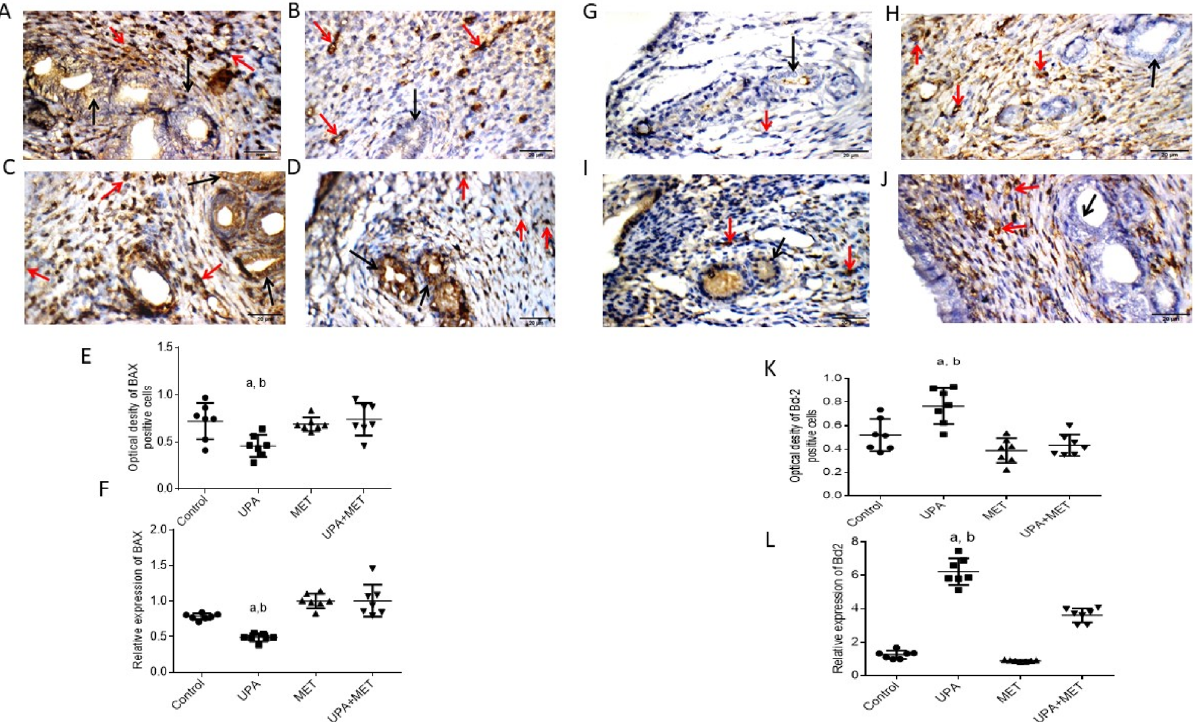
Figure 4. Effect of metformin or/and ulipristal on the expression of the proliferation markers of rats’ uteri. ( A – D ) photomicrographs of uteri shows expression of PCNA ( A ) Uterine wall in the control group. ( B ) Uterine wall in ulipristal treated group. ( C ) Uterine wall in metformin treated group. ( D ) Uterine wall in the ulipristal and metformin treated group. × 400 magnification (scale bar = 20 μm). ( E ) Expression quantification of the optical density reactivity of positive cells of PCNA by the ImageJ analysis system. ( F ) Quantitative RT-PCR analysis of PCNA mRNA expression. ( G – J ) Photomicrographs of uteri shows expression of Cyclin-D. ( G ) Uterine wall in the control group. ( H ) Uterine wall in ulipristal treated group. (I) Uterine wall in metformin treated group. ( J ) Uterine wall in the ulipristal and metformin treated group. × 400 magnification (scale bar = 20 μm). ( K ) Expression quantification of the optical density reactivity of positive cells by the ImageJ analysis system. ( L ) Quantitative RT-PCR analysis of Cyclin D1 mRNA expression, Black arrow refers to reactivity in endometrial glands, red arrows refers to reactivity in stromal cells. Data in figures ( E ) and ( K ) is represented by mean ± SD (n = 7). All value of RT-PCR is expressed as the change in cycle threshold (ΔCt). Each dot represents mean of each group (n = 7, triplicate for each rat). Negative control (DEPC-treated water) showed no detectable fluorescent signals. a or b, Statistically significant from the control or ulipristal and metformin treated group respectively at P < 0.05 using one-way ANOVA followed by Tukey as a post hoc test. UPA ulipristal, MET metformin, UPA + MET co-treatment with ulipristal and